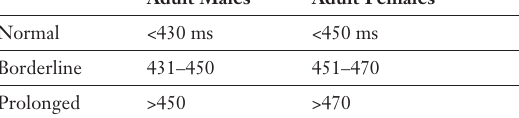
Corrected QT interval values according